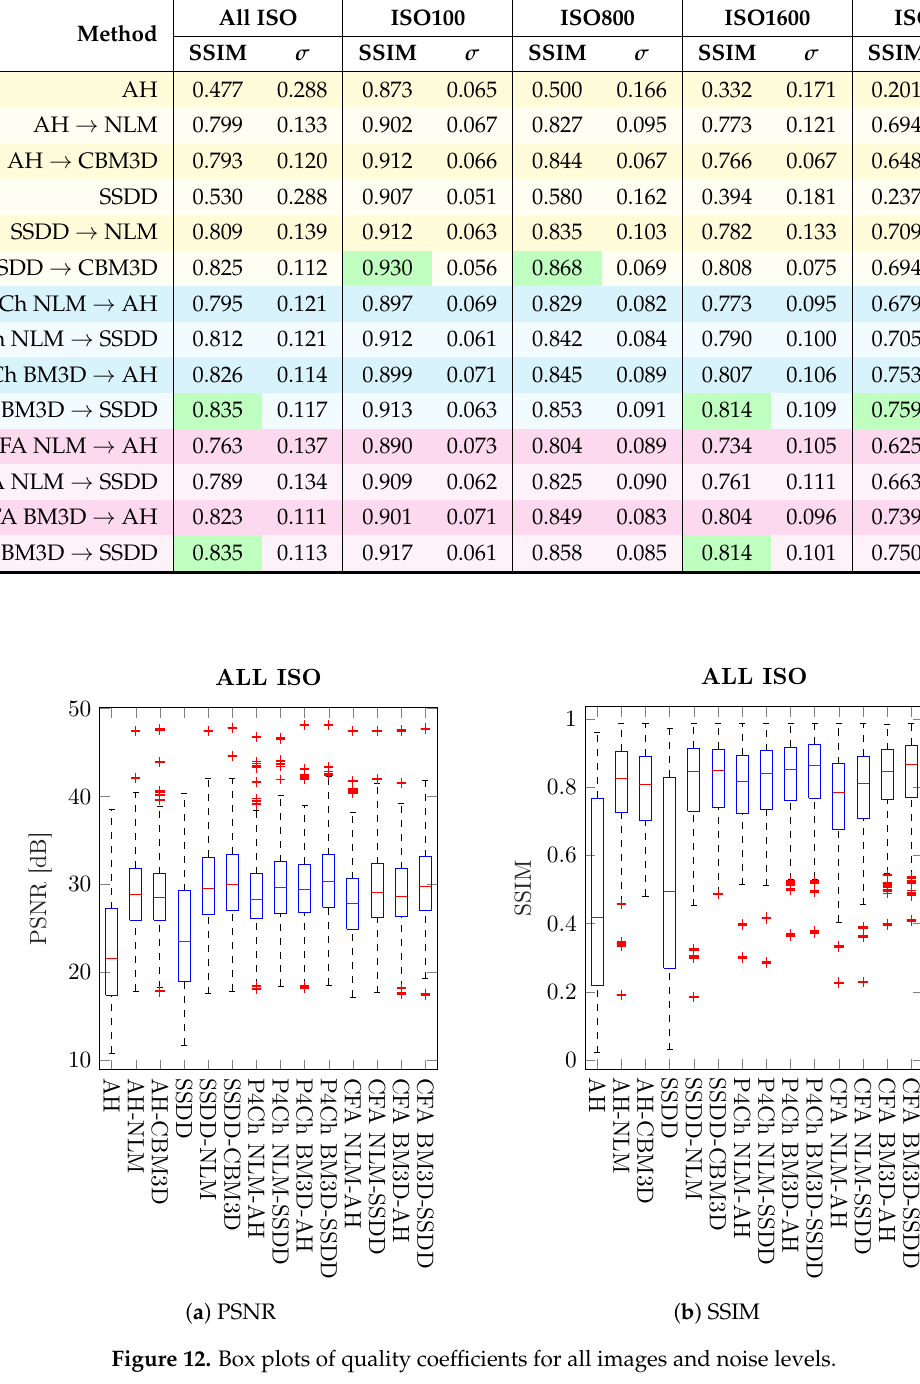
Table 3. Structural similarity index (SSIM) average results—all files.